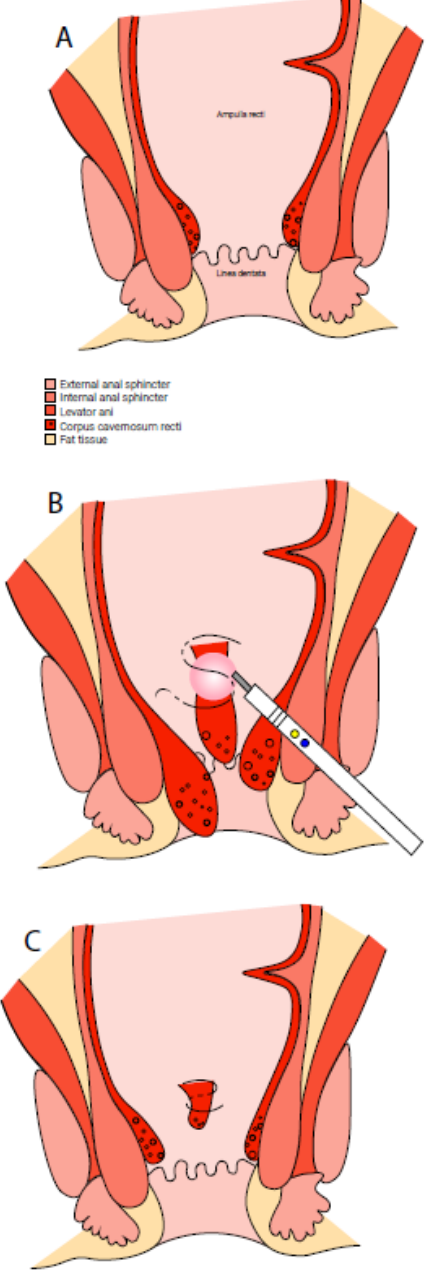
Figure 1. The procedure of the sutured haemorrhoidopexy. ( A ) Healthy situation. ( B ) Haemorrhoidal disease. A stitch is placed at the cranial side of the haemorrhoidal tissue. A mucosectomy is performed with a diathermic device. ( C ) The stitch is tightened, lifting the haemorrhoidal tissue. This procedure was performed in one to three haemorrhoidal columns depending on the severity of HD. An absorbable haemostatic gelatine tampon was inserted. No postoperative antibiotics were